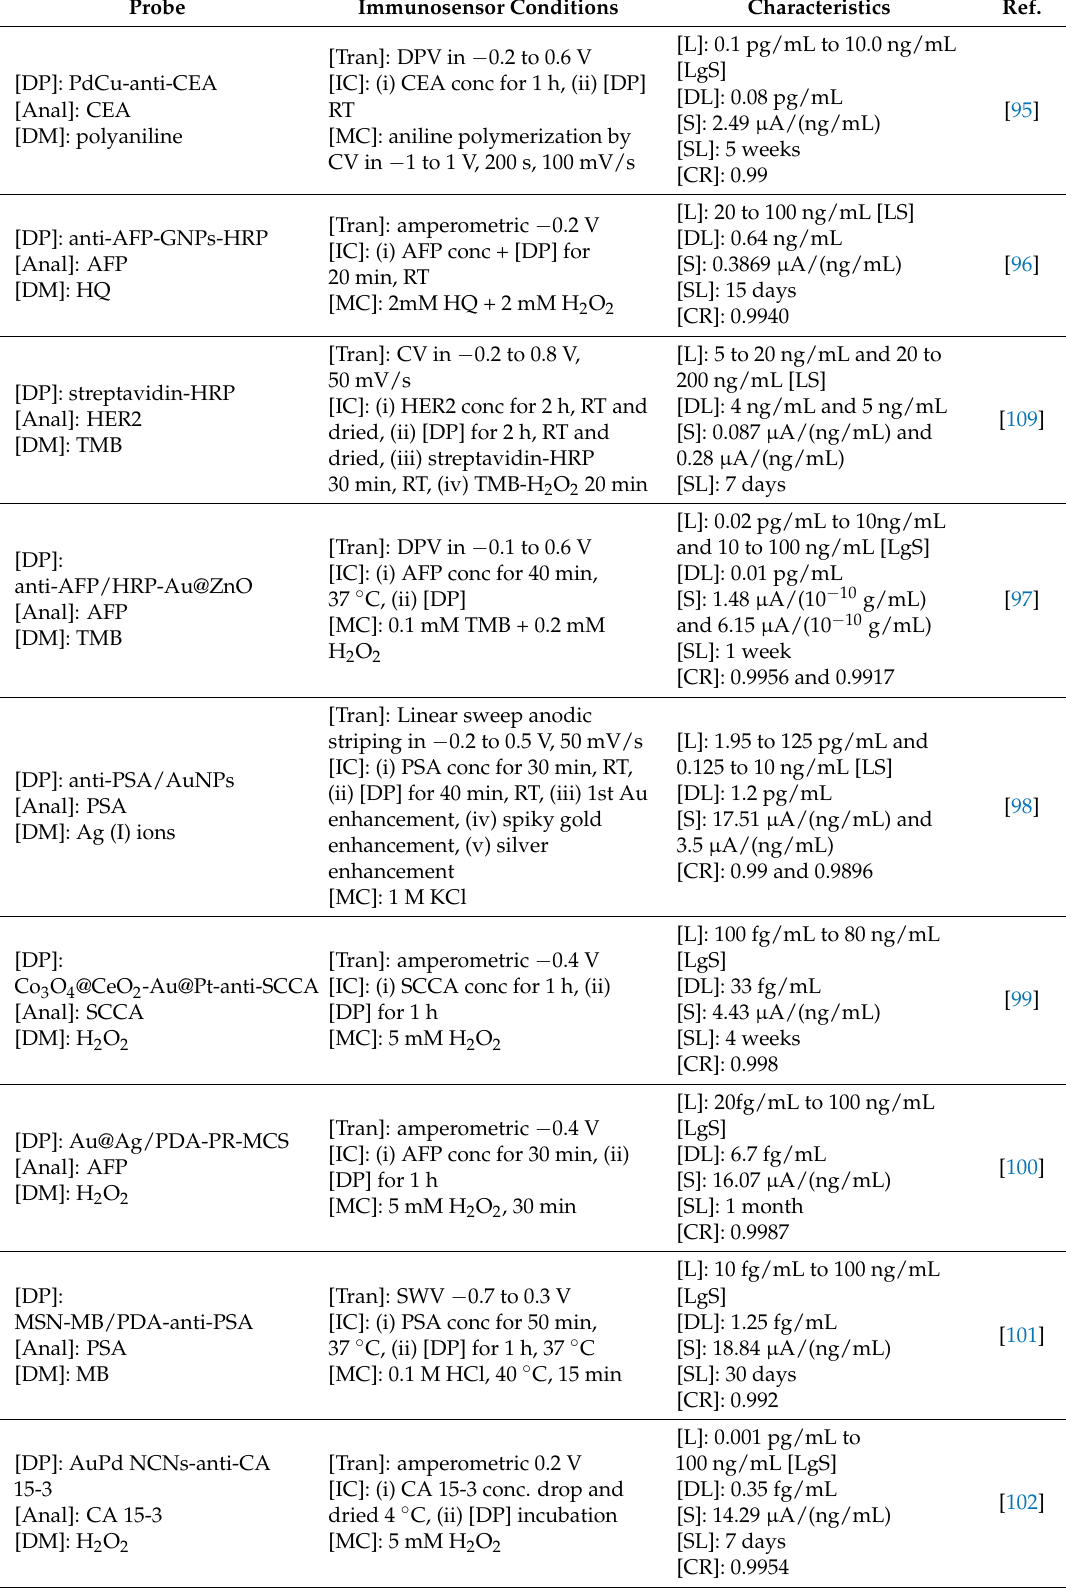
Probe Immunosensor Conditions Characteristics